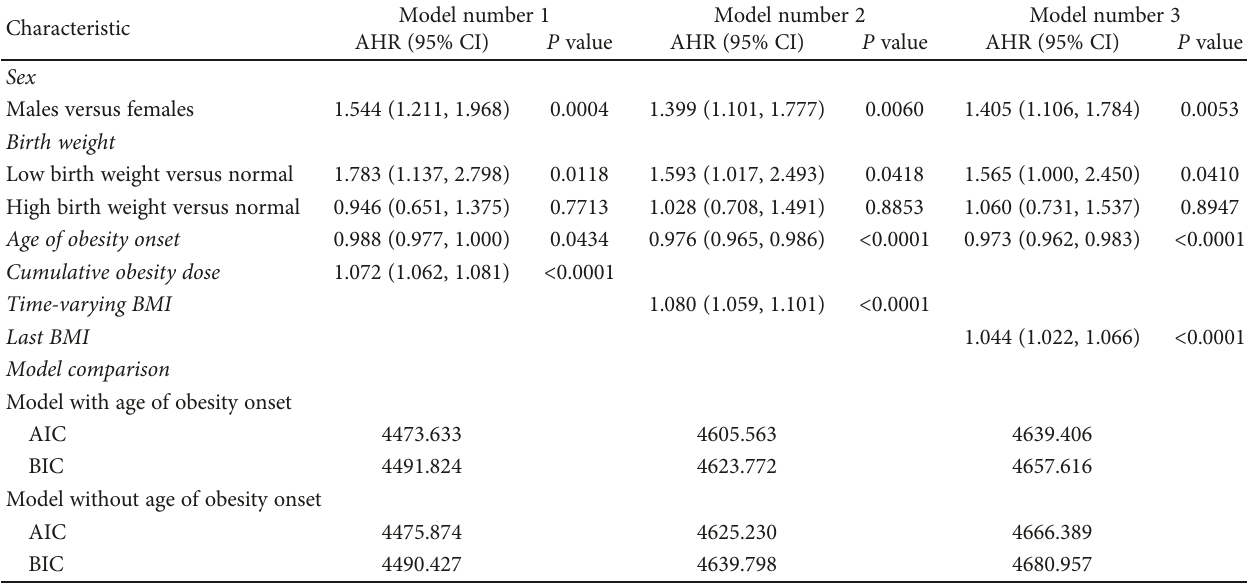
Table 4: Adjusted hazard ratios (AHRs) of developing diabetes using multivariate Cox regression analyses: participants with the overweight/ obesity onset during follow-up.